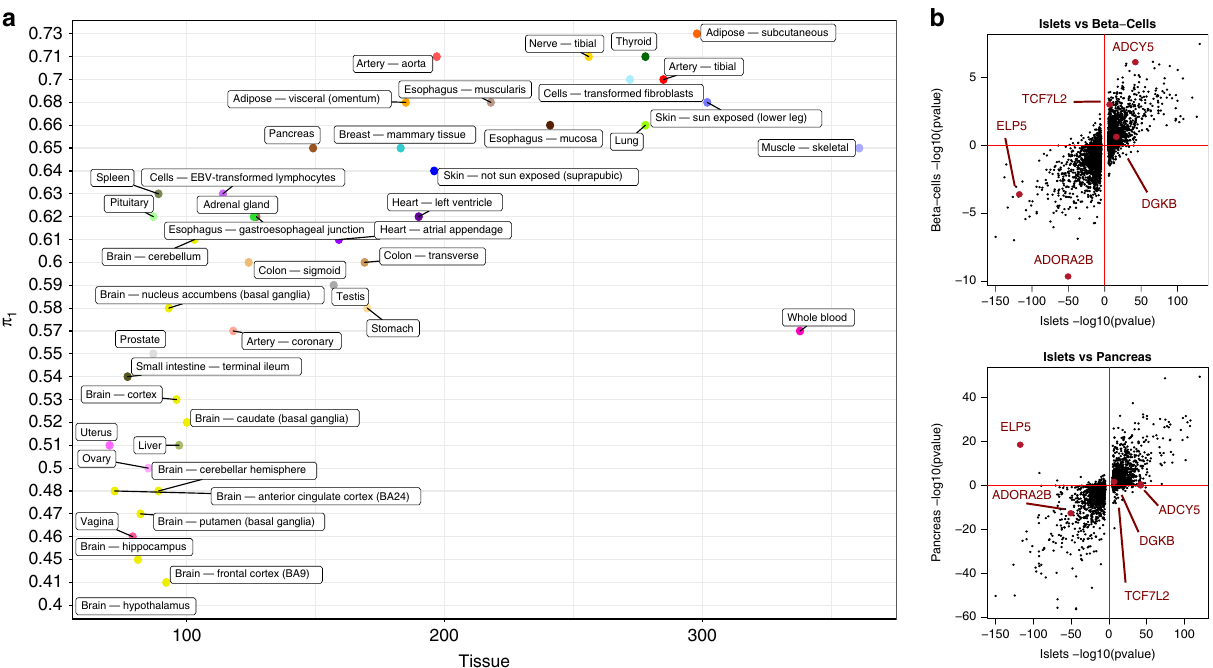
Fig. 1 Islet eQTLs and their activity in other tissues. a Proportion of islet eQTLs active in GTEx tissues using p -value enrichment analysis ( π 1 estimate for replication). b Comparison between eQTLs discovered in islets and their p -values in β -cells (top fi gure, N = 26) and whole pancreas tissue from GTEX (bottom fi gure, n = 149). The axes show the − log 10 p -value of the eQTL associations adjusted by the eQTL direction (positive or negative) of effect with respect to the reference allele. Source data are provided as a Source data fi